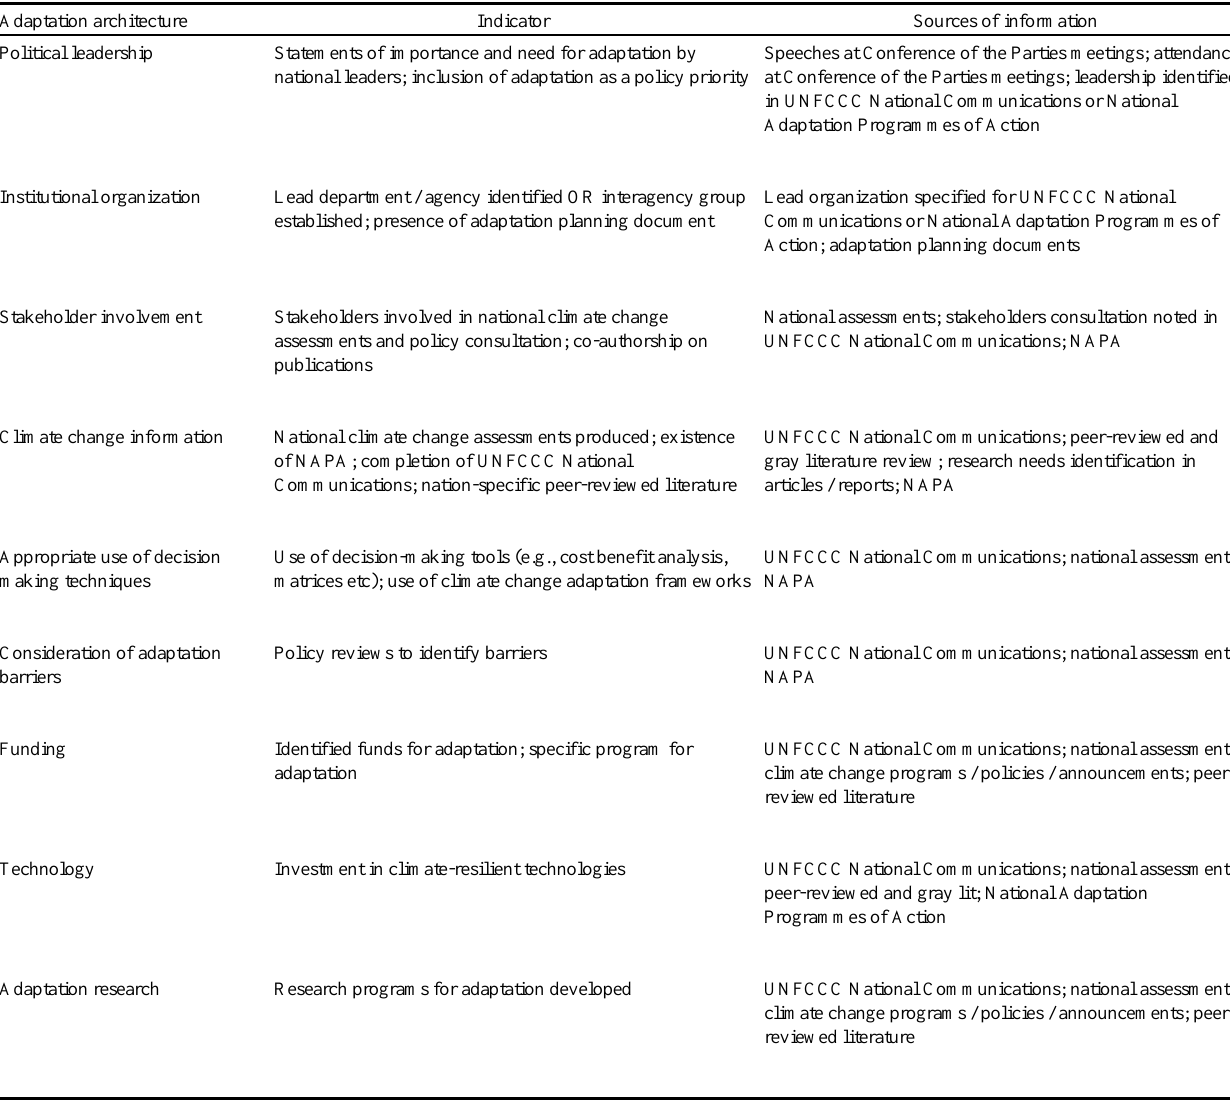
Table 2 . Potential indicators and sources of information for evaluating readiness for